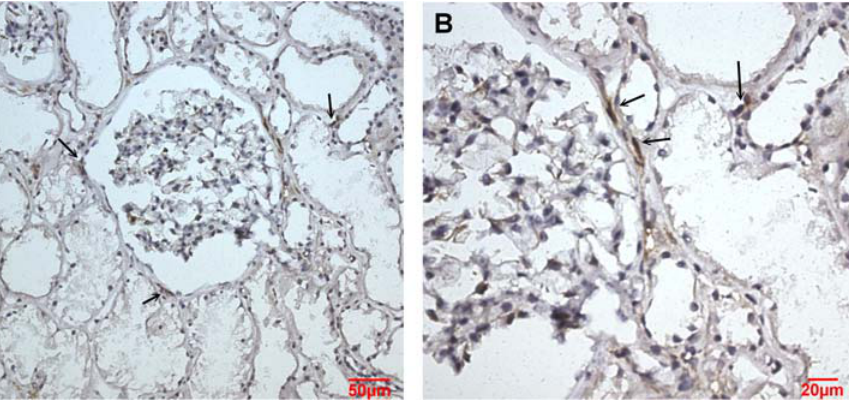
Figure 3. Renal interstitial cells located between tubuli or at the border of glomeruli express cadherin-9. Cadherin-9-positive cells were identified by immunohistochemical staining with the affinity-purified anti-cadherin-9 polyclonal antibody. The sections were counterstained with hematoxylin- eosin. Arrows point to some of the cadherin-9 expressing cells. Panel B shows a part of A in a higher magnification. Bars: (A) 50 m m, (B) 20 m m. doi:10.1371/journal.pone.0000657.g003 PLoS ONE |